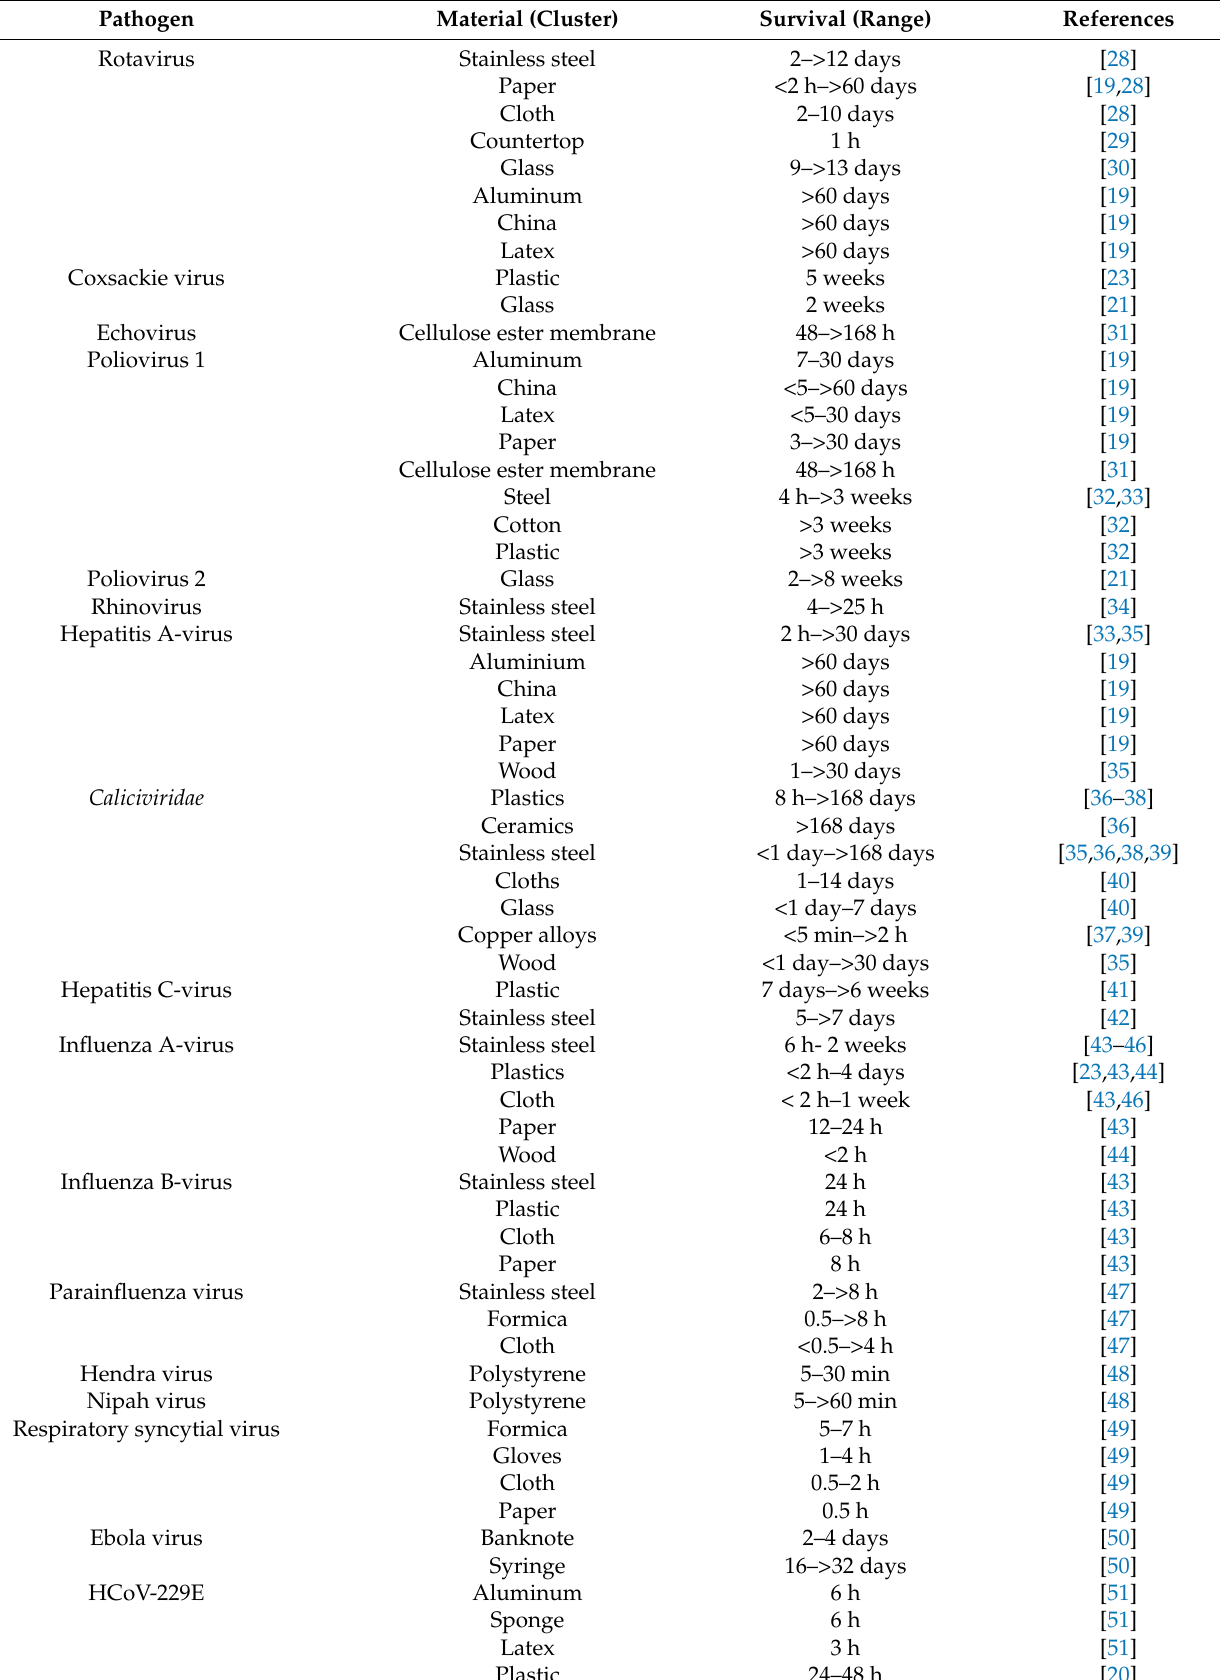
Table 2. Survival of RNA